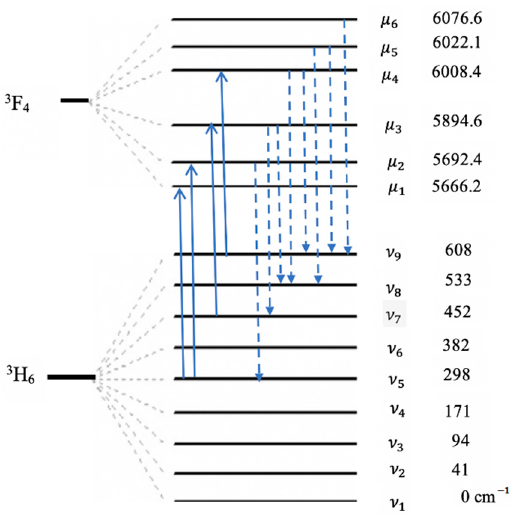
Figure 1. Energy levels scheme of 3 H 6 and 3 F 4 manifolds Tm 3+ ion in LN [9].